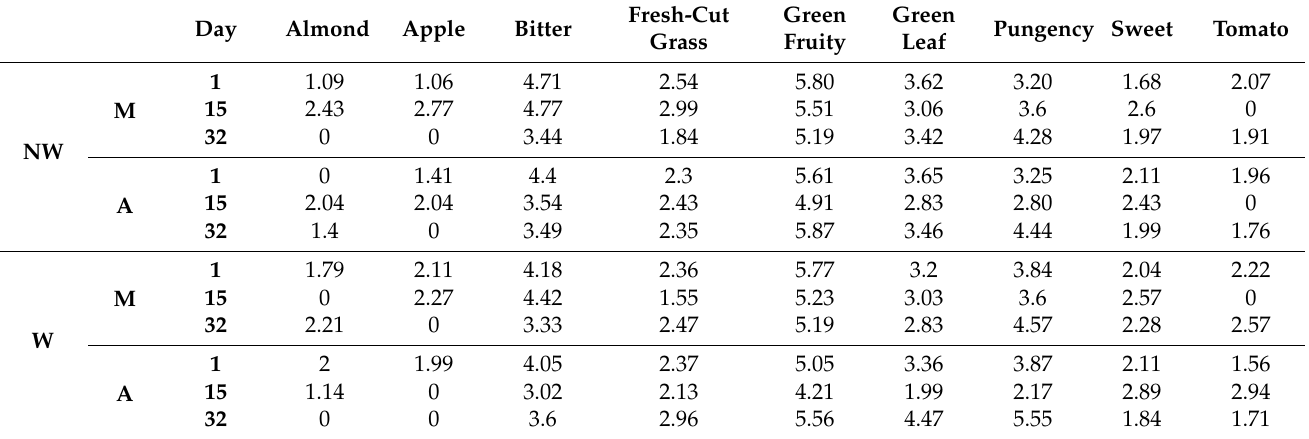
Table 2. Sensory profile of Picual Organic Extra Virgin Olive Oil (OEVOO) depending on the sampling day (1, 15 and 32) and the time of collection (morning or afternoon) and the washing process.